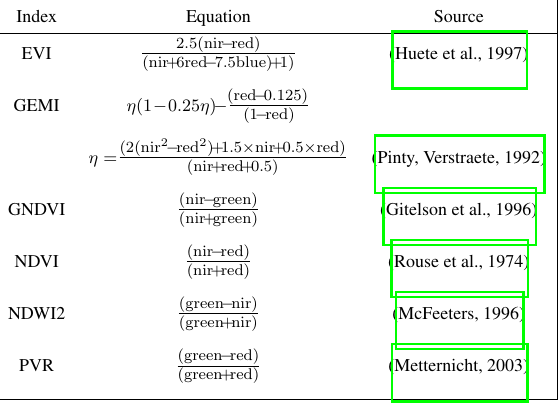
Table 2. Summary of the vegetation